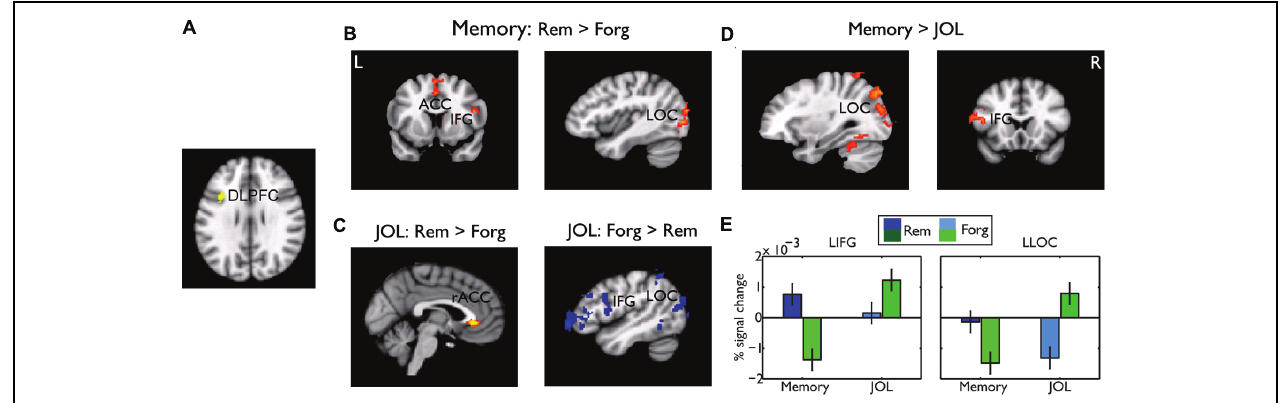
FIGURE 6 | Psychophysiological interaction (PPI) results. (A) The seed region for the PPI analysis, the DLPFC, which showed a common effect for memory performance and JOL. (B) Brain regions showing stronger functional connectivity with the DLPFC for remembered than forgotten trials. (C) Brain regions showing stronger (red-yellow color, uncorrected, p < 0.01) and weaker (blue color) functional connectivity for “will be remembered” than “will be forgotten” trials. (D) Brain regions showing significant differences in functional connectivity between memory performance and JOL. Unless otherwise stated, all activations were thresholded at Z > 2.3 (whole-brain corrected p < 0.05). (E) Bar graphs of the functional connectivity in the left LOC and IFG, as a function of subsequent memory or JOL. Error bars denote within-subjects standard